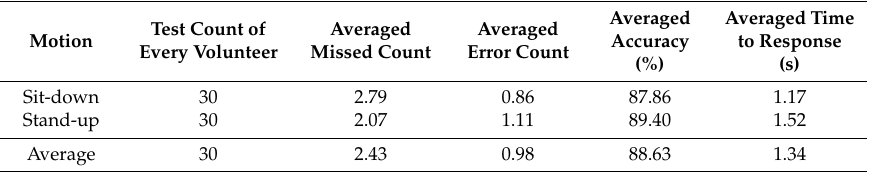
Table 7. Performance of the online real-time pattern